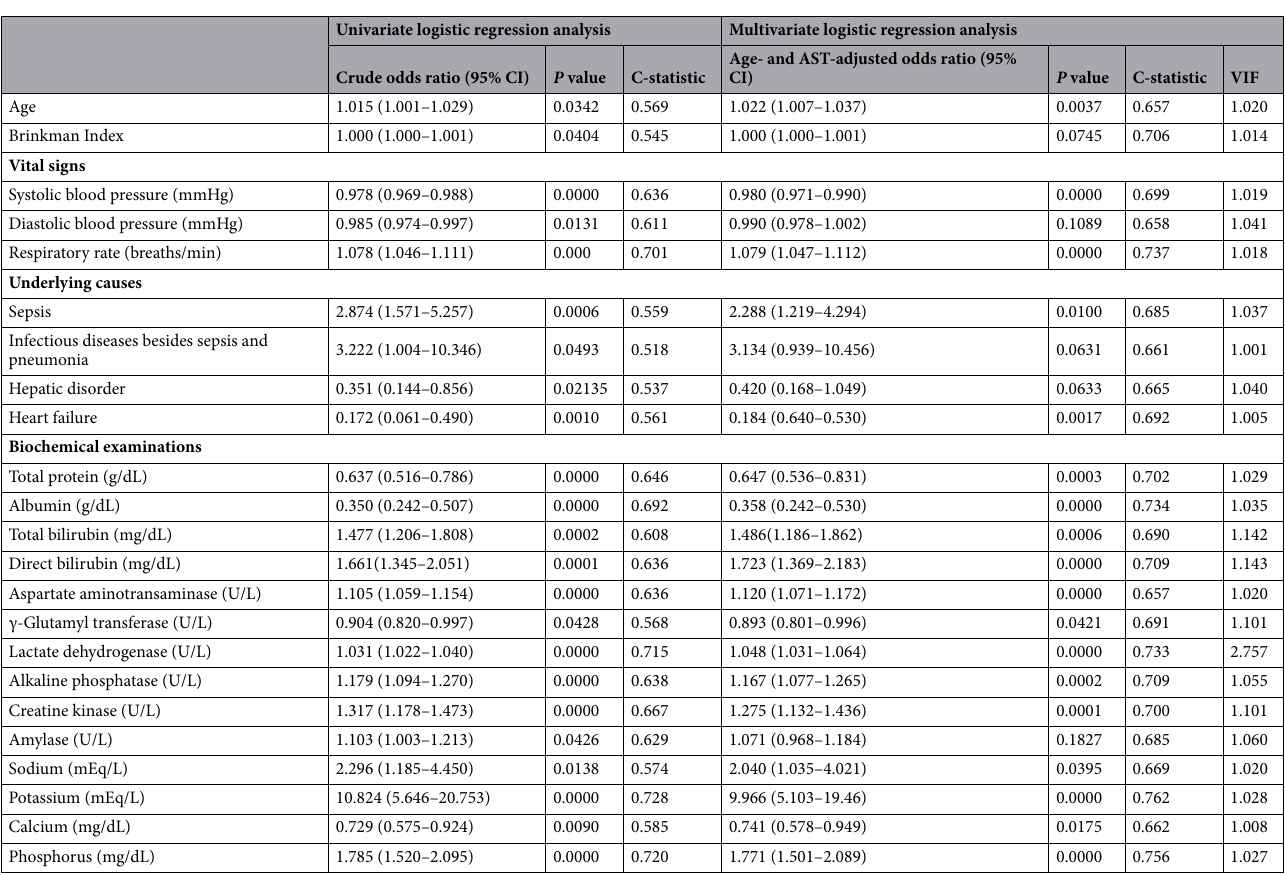
Table 3. Univariate and multivariate logistic regression analyses of specific variables. CI, confidence interval; AST, aspartate aminotransferase; VIF, variance inflation factor. P -values were calculated using the χ 2 test.